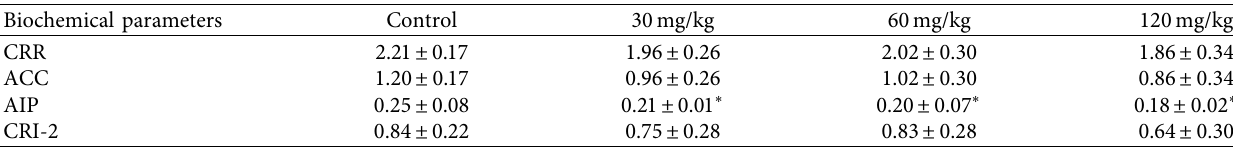
Figure 3: The effects of goose bone on lipid profile. Results are expressed as mean ± SD ( n � 8). ∗ denotes level of significant difference when compared to the control group as determined using a one-way ANOVA followed by Dunnett’s multiple comparison tests. Table 6: The effects of goose bone on atherogenic indices.